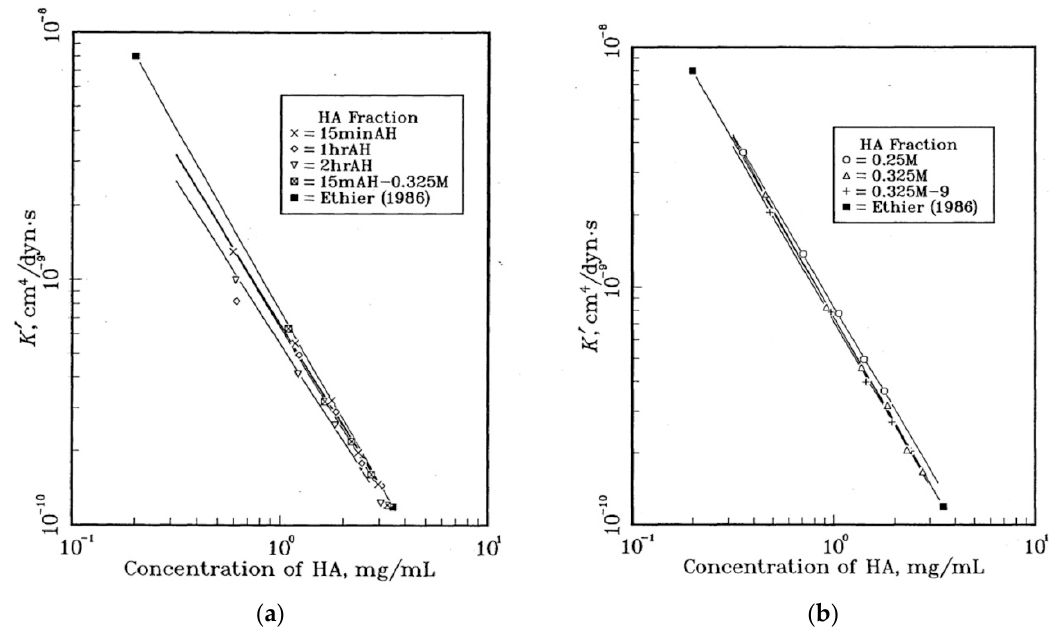
Figure 18. Dependence of hydraulic flow conductivity of hyaluronic acid solutions on biopolymer concentration, where HA has a variety of molecular weights: ( a ) 15minAH — 165 kDa, 1hrAH – 81.9 kDa, 2hrAH – 45.4 kDa, 15minAH—0.325M – 196 kDa, Ethier (1986) [106]; ( b ) 0.25M – 699 kDa, 0.325M – 844 kDa, 0.325M—9 – 1110 kDa, Ethier (1986) [106] (reproduced from [104], with permission from University of British Columbia, 2020).